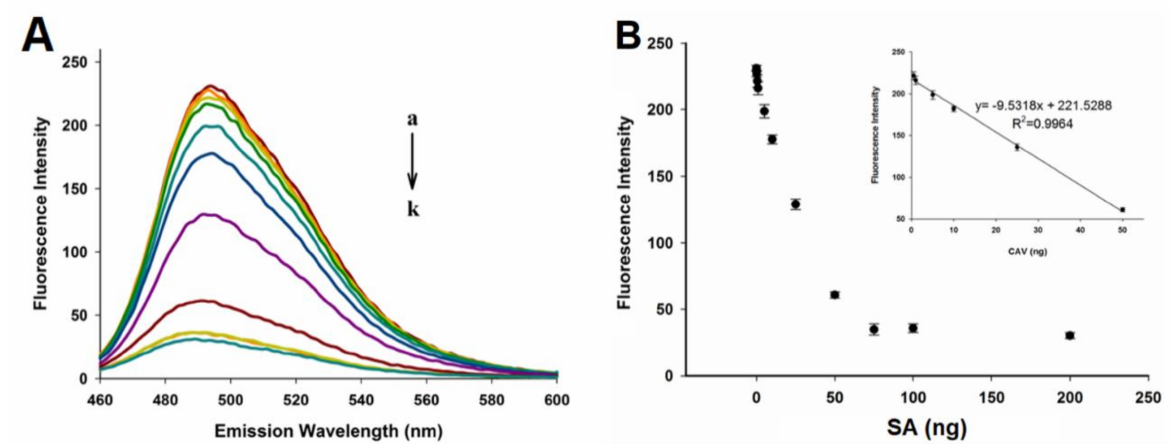
Figure 2. The SA detection by the G3MB1-b biosensor. ( A ) Fluorescence spectra of the solution contained G3MB1-b, ThT and Exo III after incubation with varying concentrations of SA: (a) 0; (b) 0.1 ng; (c) 0.5 ng; (d) 1 ng; (e) 5 ng; (f) 10 ng; (g) 25 ng; (h) 50 ng; (i) 75 ng; (j) 100 ng; (k) 200 ng. The fluorescence experiments were carried out in 1 X Tris-HCl buffer (25 mM Tris-HCl, 50 mM KCl, pH = 7.4) for 2 h at 37 ◦ C before fluorescence measurement. The excitation wavelength was set at 435 nm, and the fluorescence spectra was collected from 460 nm to 600 nm at room temperature. ( B ) The relationship between the fluorescence signal and the concentrations of SA. Insert: Linear relationship between the fluorescence intensity and the concentration of SA. Error bars represented the standard deviation of three parallel